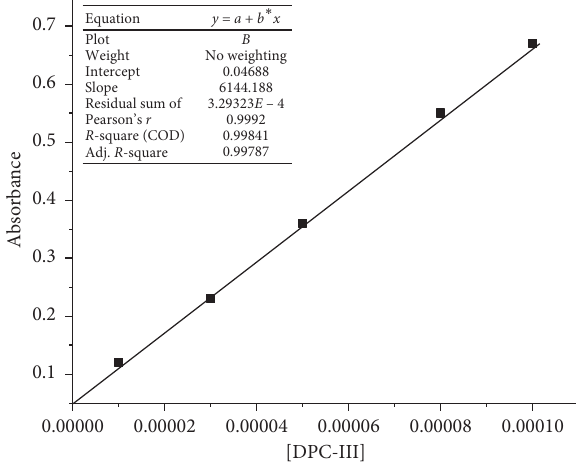
Figure 3: Plot of absorbance vs. [DPC] at 25 °